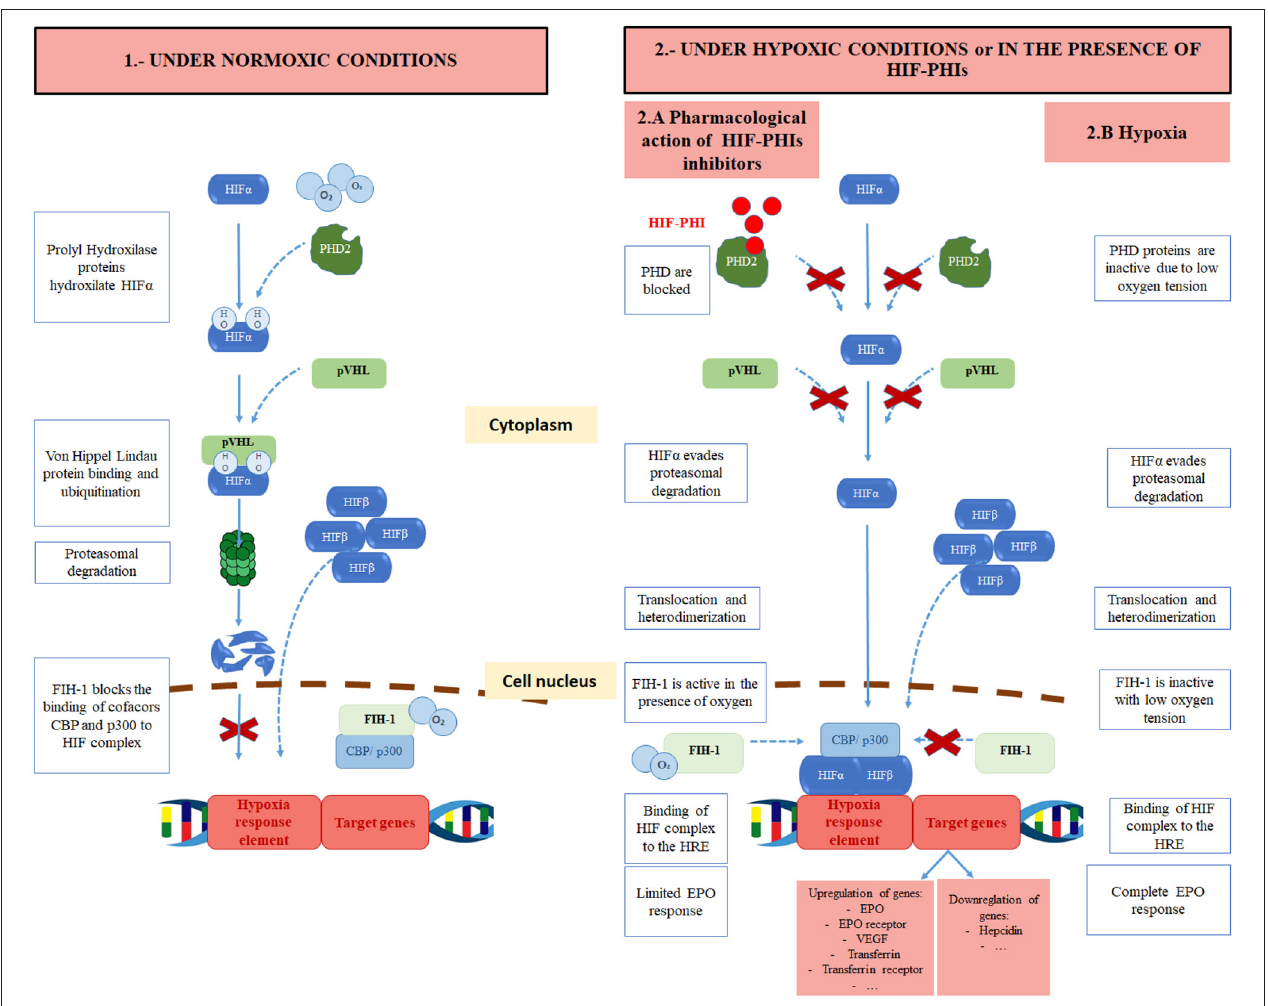
FIGURE 1 | Regulation of HIF under normoxic conditions, pharmacological effects of hypoxia-inducible factor prolyl hydroxylase inhibitors (HIF-PHIs) and under hypoxic conditions. HIF, hypoxia-inducible factor; O 2 , oxygen; OH, hydroxyl; PHD, prolyl hydroxylase domain protein; HIF-PHI, hypoxia inducible factor prolyl hydroxylase inhibitor; pVHL, Von Hippel Lindau protein; FIH-1, Factor inhibiting HIF; CBP, CREB-binding